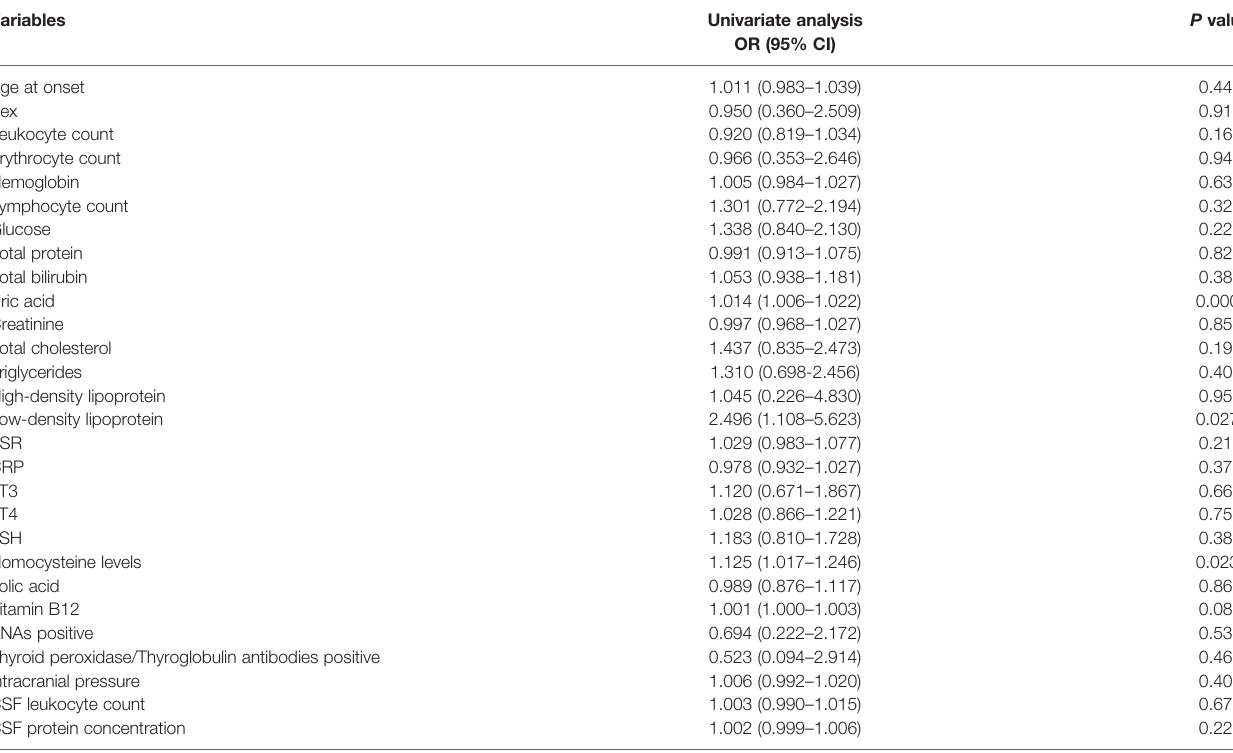
TABLE 6 | Univariate logistic regression analysis of potential predictive factors for the severity at the onset of myelin oligodendrocyte glycoprotein antibody disease.